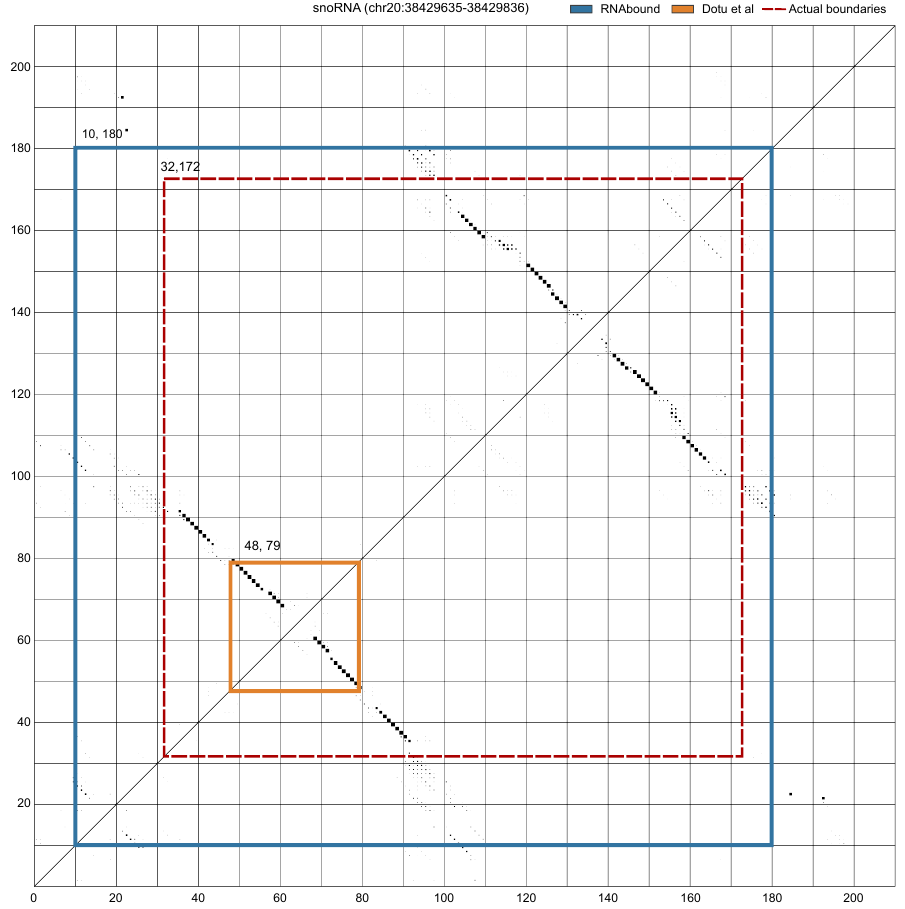
Figure 3. Dot plot shows the PETfold base pairing probabilities computed from the multiple sequence alignment of a window 200 nts centered on an H/ACA-box snoRNA (RF00056). Each dot corresponds to base pairing of two bases in the respective positions (along the x- and y-axis) and the size of the dot corresponds to the probability. The bigger the size the higher the pairing probability. Due to the gaps in the multiple sequence alignment, the size of dot plot exceeds the window size 200 nts. The actual and predicted boundaries of the snoRNA are highlighted in the plot: ( a ) actual boundaries (31, 172—red dashed lines); ( b ) RNAbound predicted boundaries (10, 180—blue lines); and ( c ) Dotu et al. prediction (48, 79 orange lines). RNAbound predicted an excess of boundaries, 22 bases on the left and eight bases on the right, as compared to actual boundaries. However, the Dotu et al. approach predicted short of boundaries, − 16 and − 93, respectively, on the left and right boundaries, as compared to actual